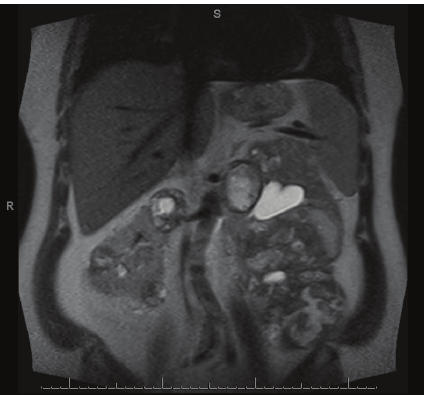
Figure 1: Preoperative abdominal MRI.